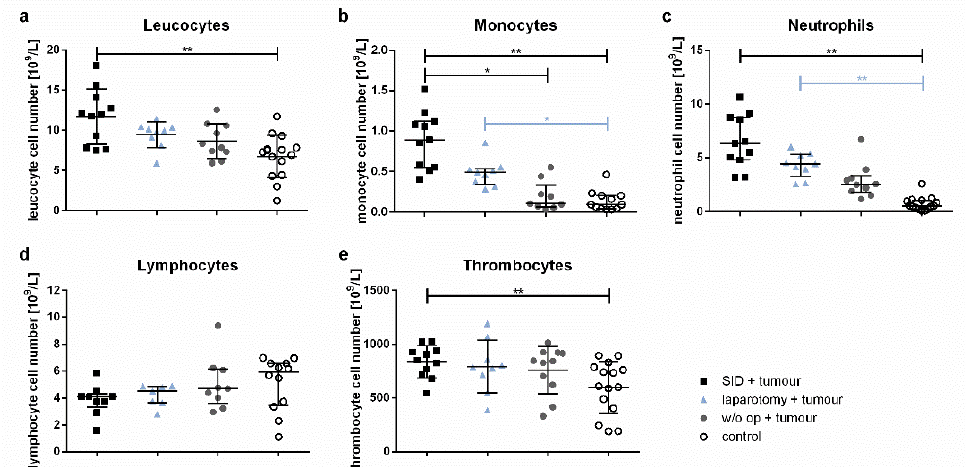
Figure 6. Blood cell counts. The blood cell counts of the venous blood samples were determined by a veterinary haematology analyser. The graphs show ( a ) the total leucocyte cell numbers, ( b ) monocyte, ( c ) neutrophil, ( d ) lymphocyte, and ( e ) thrombocyte cell numbers. Values in ( a , e ) are the mean and standard error; values in ( b – d ) represent the median and interquartile ranges with n = 9–15 animals per group (SID + tumour: n = 11; laparotomy + tumour: 9; w/o op + tumour: 11; control: 15); * p < 0.05; ** p < 0.01.